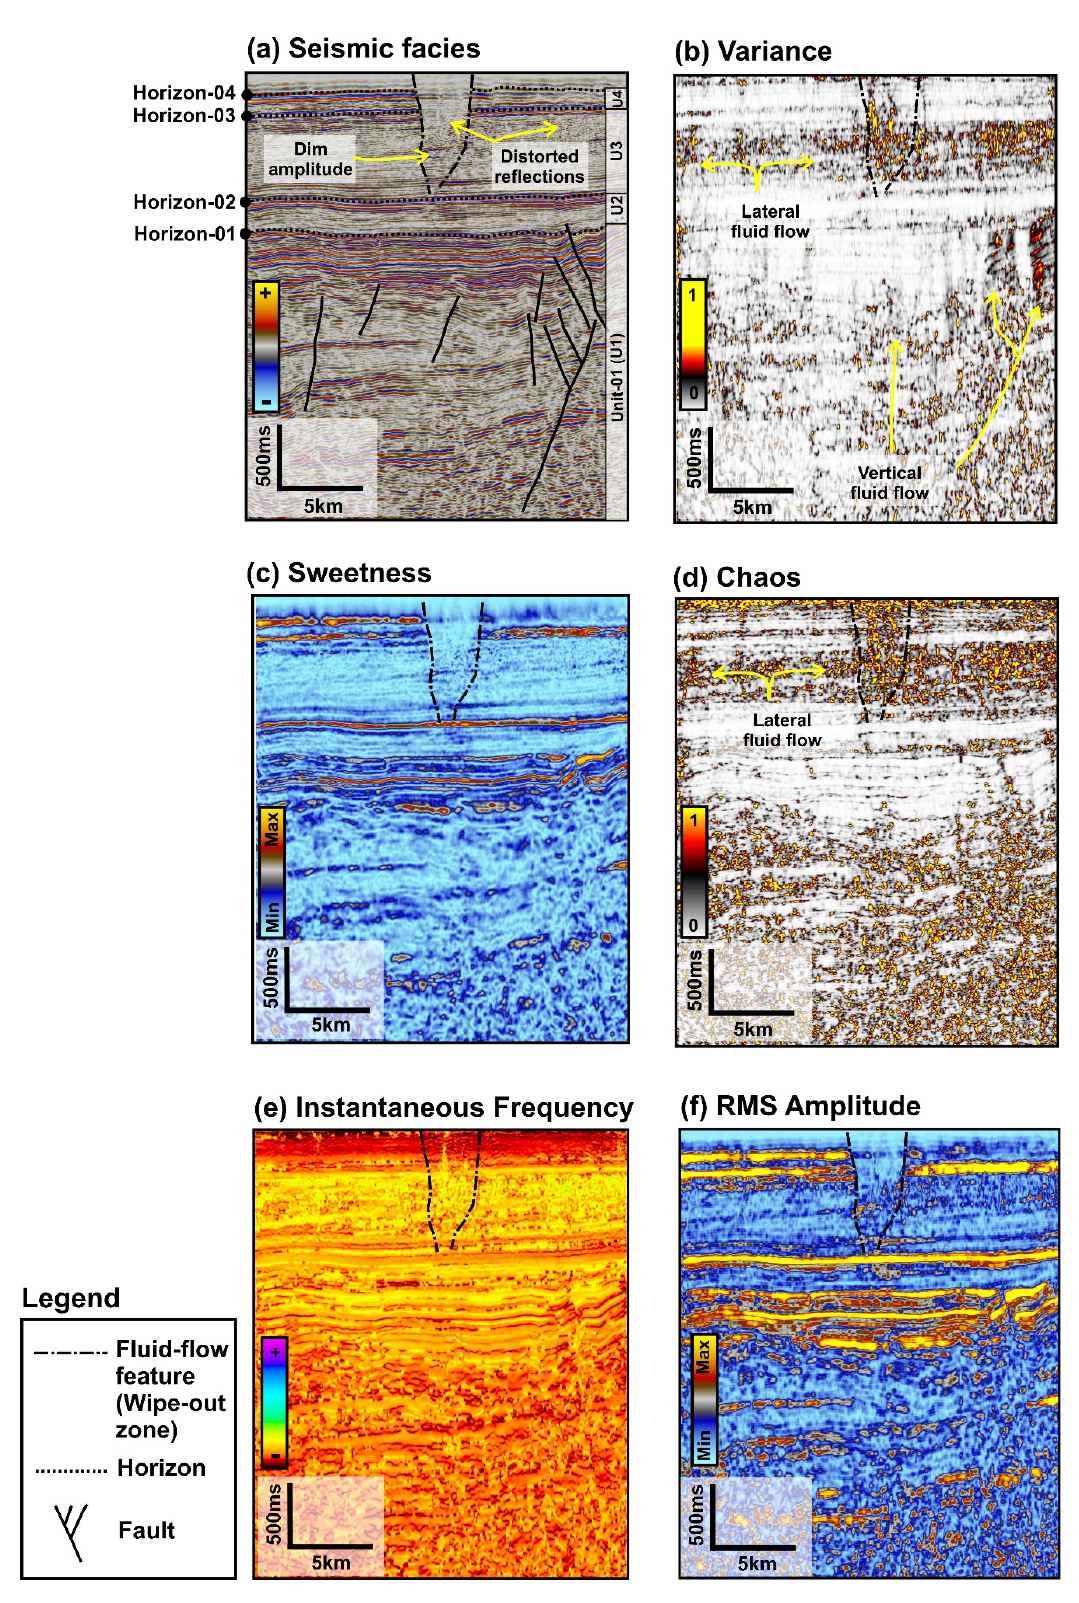
Figure 5. ( a ) Seismic facies and seismic attributes of line 4; ( b ) variance, ( c ) sweetness, ( d ) chaos, ( e ) instantaneous frequency, and ( f ) RMS amplitude, with fluid flow feature interpretation. See Figure 1a for section location.